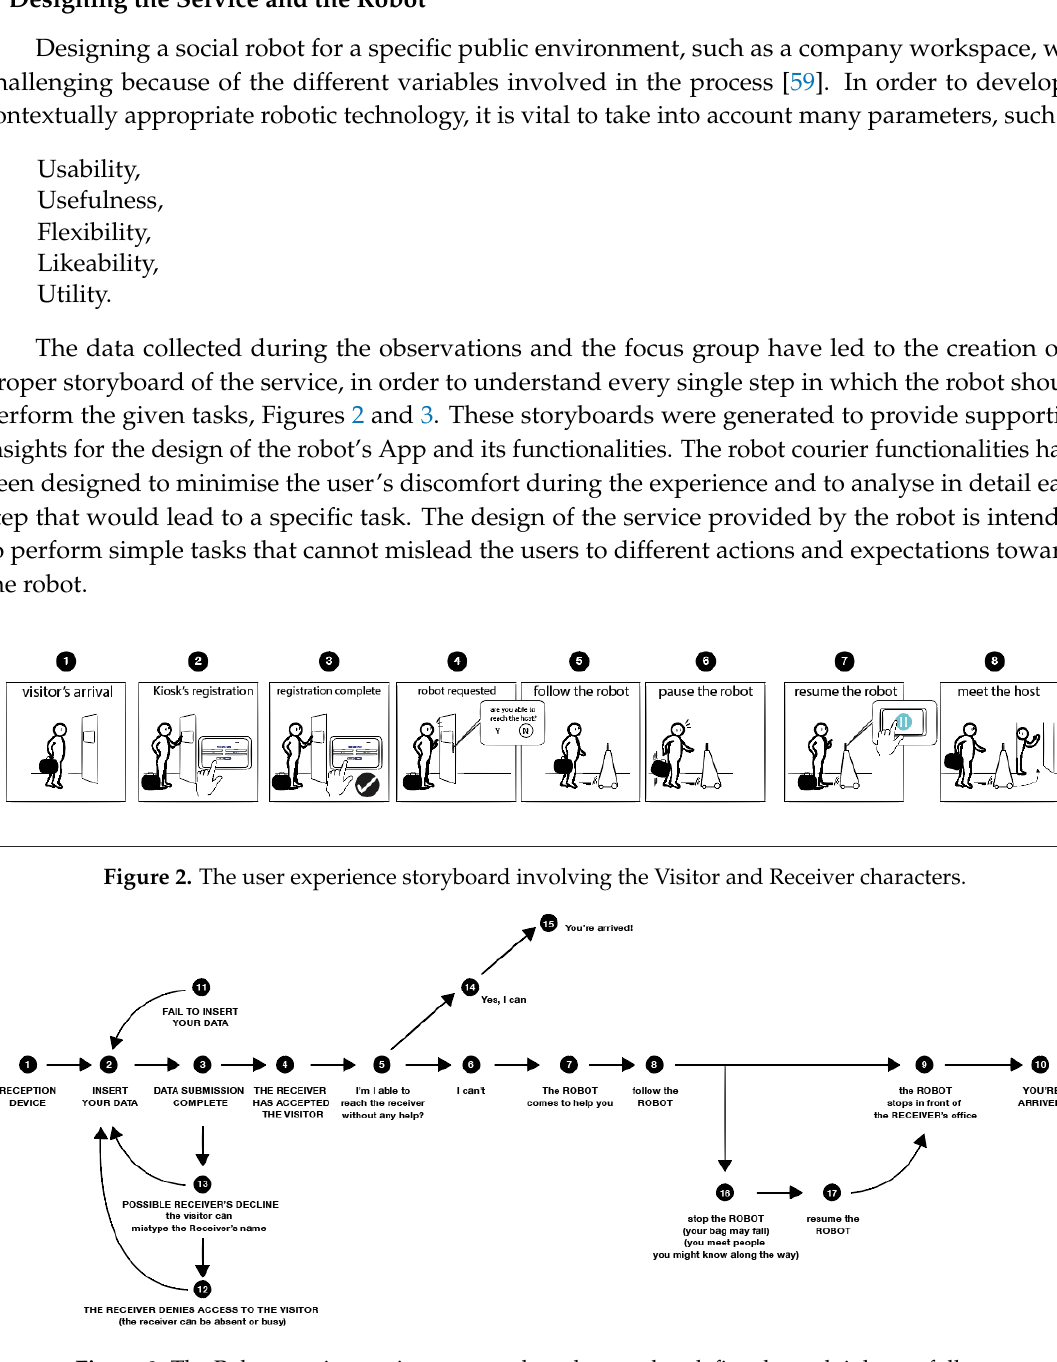
Figure 3. The Robot courier service text storyboard created to define the path it has to